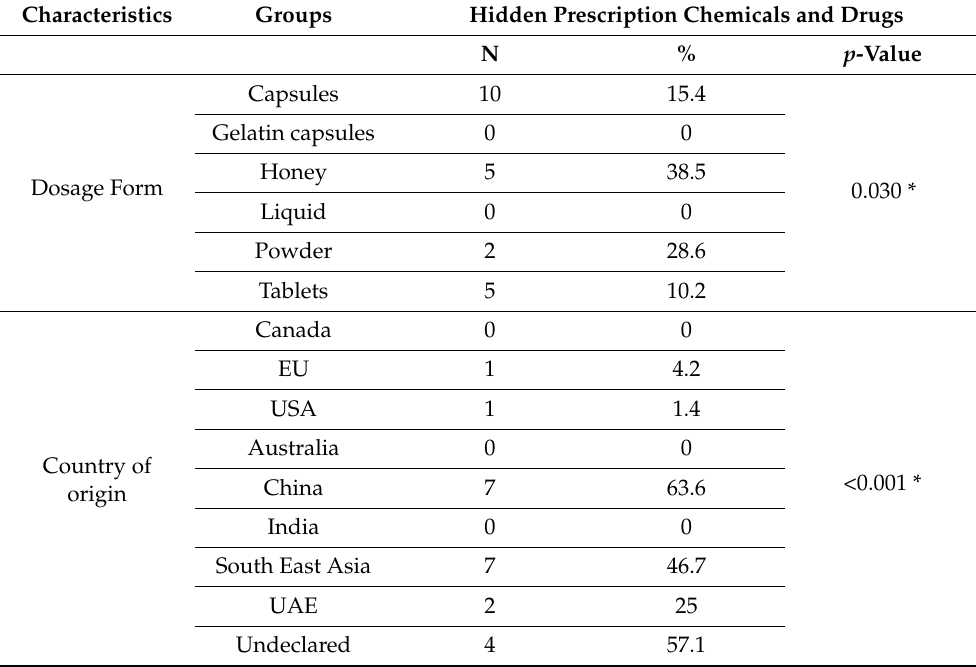
Table 4. Comparison of hidden prescription chemicals and drugs according to the sample characteristics.